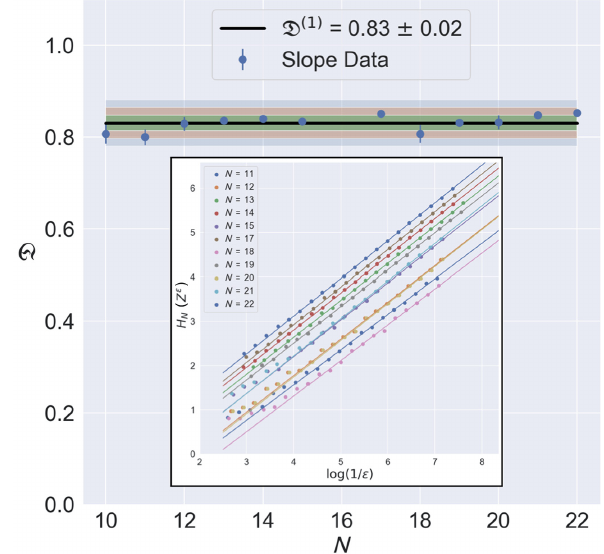
FIG. 10. Schematic depiction of numerically extracting D ∞ by examining systems with progressively larger system size N , while at each size we estimate two scaling curves. At their overlap a linear increase with − log (cid:11) is present. This permits estimating D ∞ with the slope of the tangent there. In this ideal case, this is exactly identical to D ∞ for each N . In reality, finite- size effects mean that the data are noisy and the estimation is harder; cf. Fig. 11.